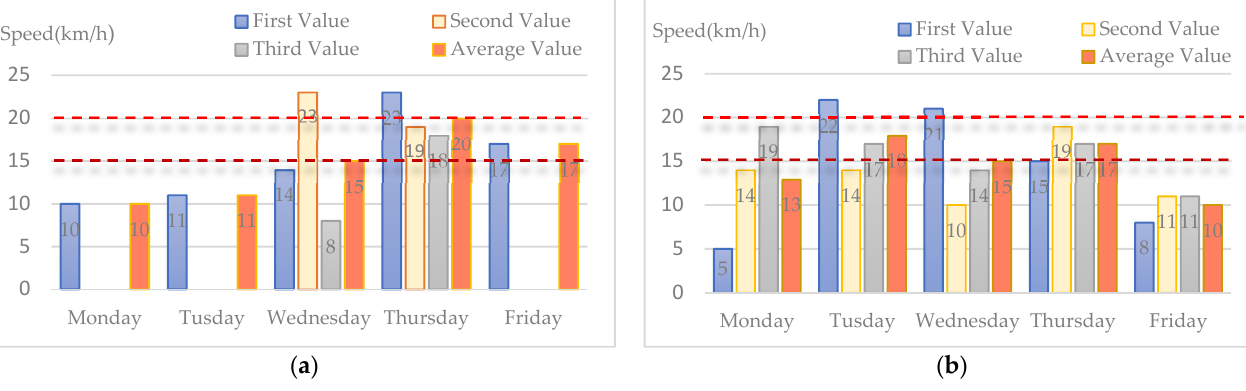
Figure 6. The taxies speeds during the working days. ( a ) The taxies speeds on the East third Ring Road during morning peak traffic hours; ( b ) The taxies speeds on the West fourth Ring Road during evening peak traffic hours.